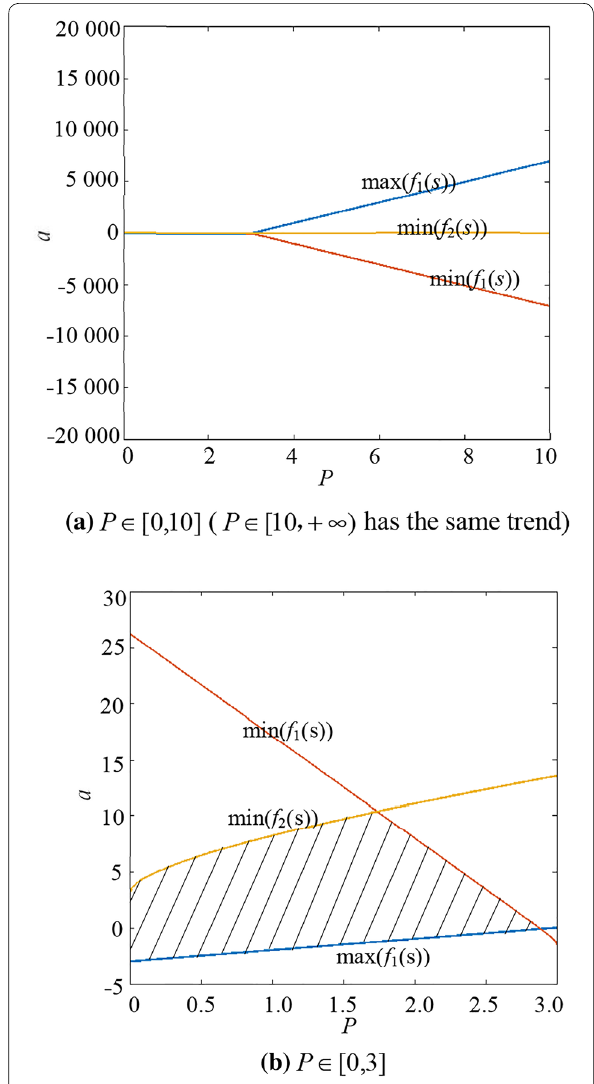
Figure 2 Derivation of the sail‑like constrained